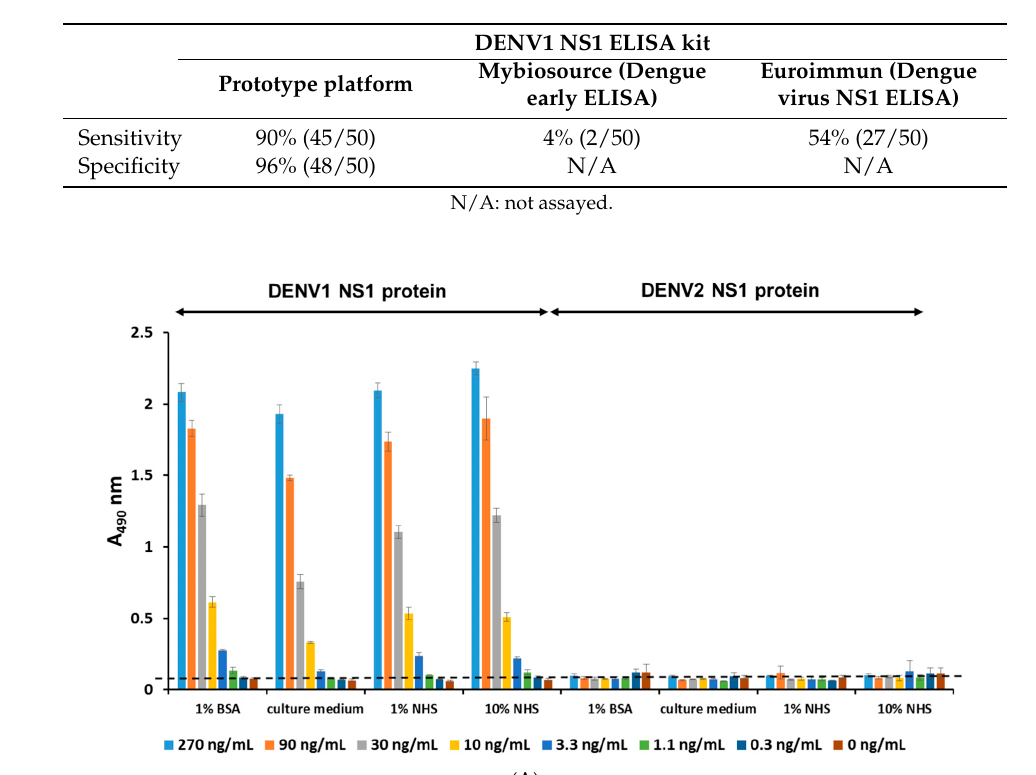
Table 2. Sensitivity and specificity of three different NS1 ELISA platforms.